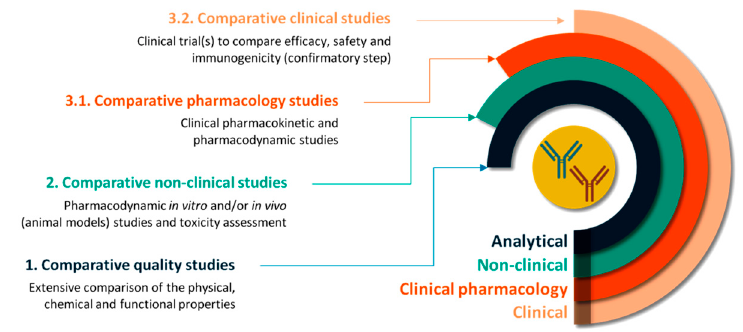
Figure 1. The step-wise process of the comparability exercise required to demonstrate the biosimilarity of a trastuzumab biosimilar to its reference product.